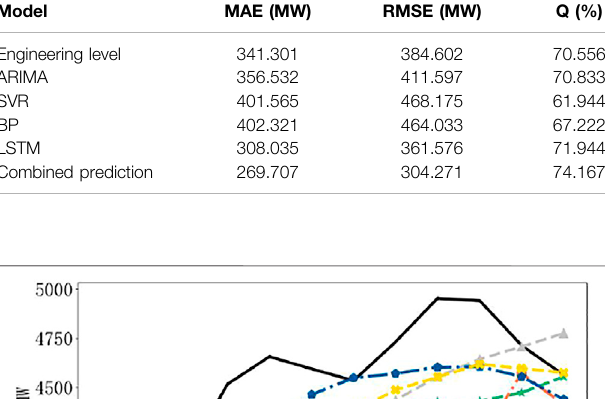
FIGURE 9 | MAE box diagram of each model.